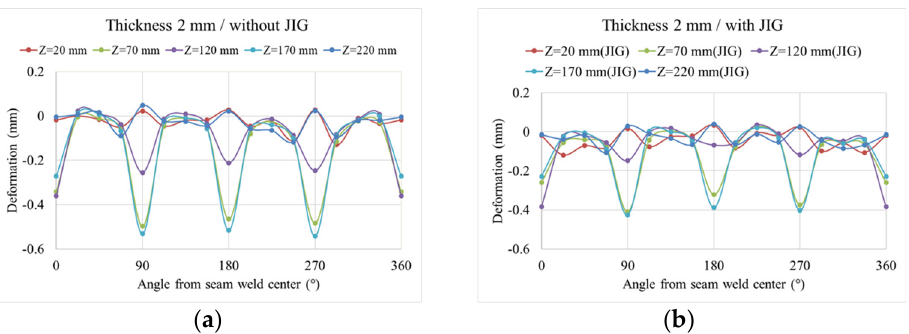
Figure 16. Weld deformation in the radial direction according to the circumferential direction at thickness 2 mm: ( a ) without jig; ( b ) with jig.